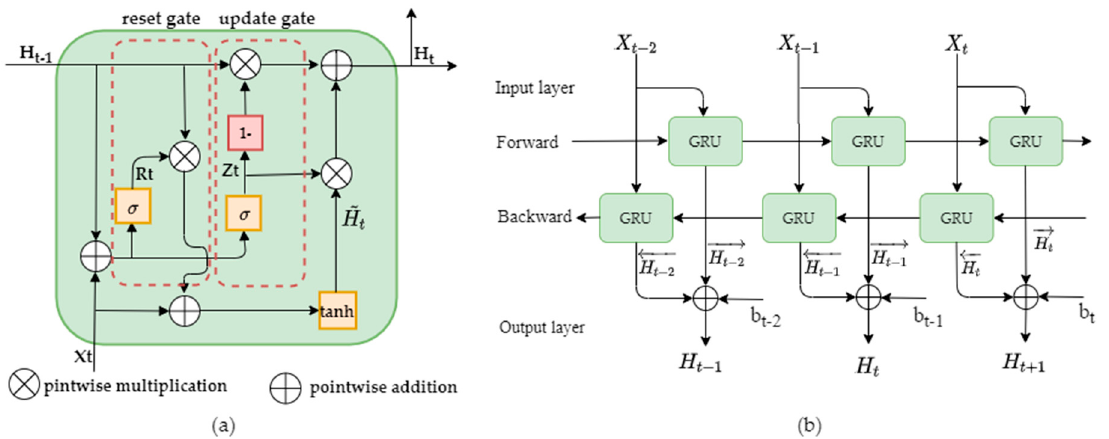
Figure 3. ( a ) Basic GRU structure; ( b ) bidirectional GRU.